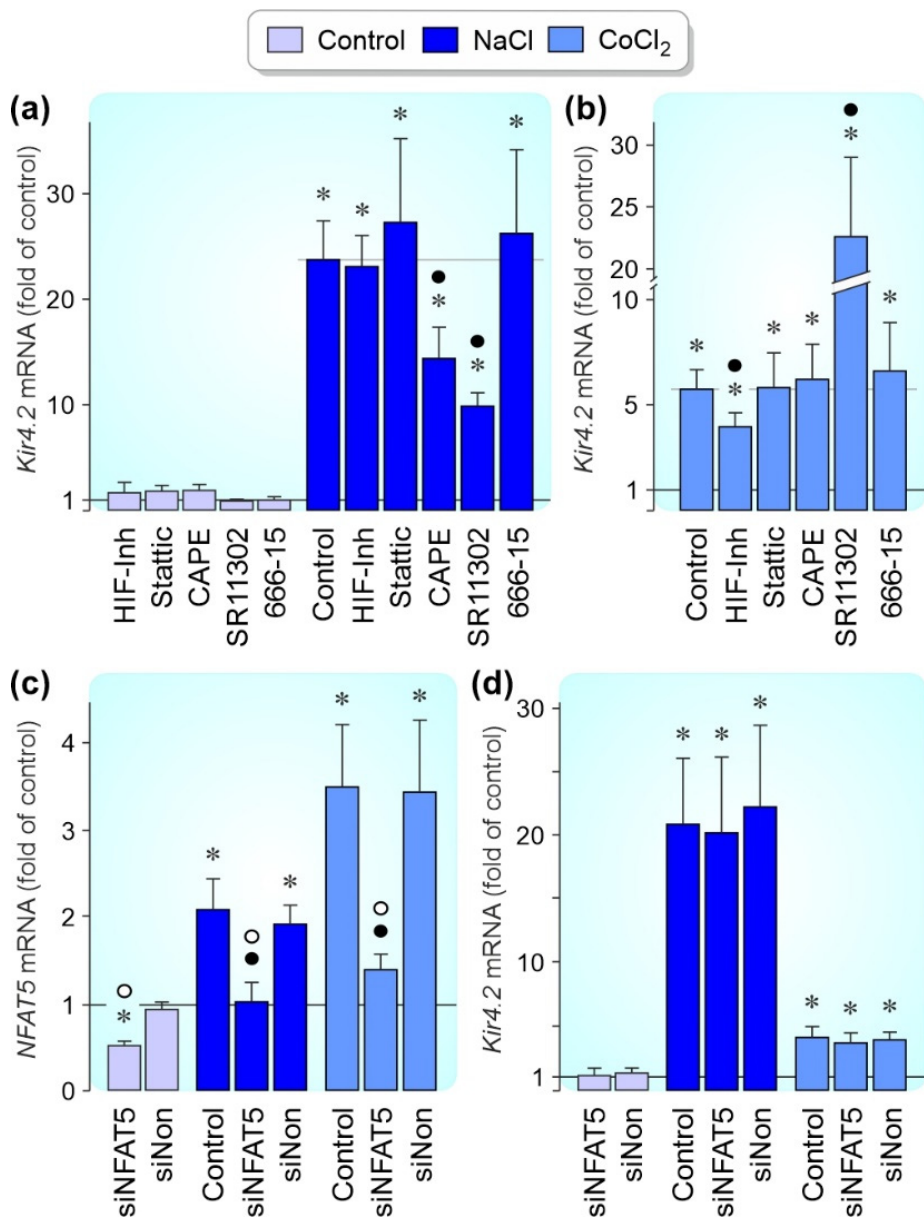
Figure 5. Activities of transcription factors which mediate the hyperosmotic and CoCl 2 -induced expression of the Kir4.2 gene in cultured RPE cells. mRNA levels were examined with real-time RT-PCR analysis. Relative mRNA levels are shown as fold of unstimulated control (1). ( a , b ) The cells were maintained 24 h in the absence (control) and presence of high (+100 mM) NaCl ( a ) and CoCl 2 (150 µM; ( b )), respectively. The effects of a HIF-1 inhibitor (HIF Inh; 5 µM), the STAT3 inhibitor Stattic (1 µM), the NF- κ B inhibitor CAPE (5 µM), the AP-1 inhibitor SR11302 (5 µM), and the CREB inhibitor 666-15 (250 nM) were tested. ( c ) Transfection of the cells with NFAT5 siRNA (siNFAT5; 5 nM) resulted in a reduction of the NFAT5 mRNA level in RPE cells cultured 24 h in the absence (control) and presence of high (+100 mM) NaCl and CoCl 2 (150 µM), respectively. Nontargeted scrambled siRNA (siNon; 5 nM) had no effects. ( d ) Knockdown of NFAT5 gene expression with siRNA (siNFAT5; 5 nM) did not alter the Kir4.2 mRNA level in cells cultured under the three conditions tested. Each bar represents data obtained in 3–7 independent experiments using cells of different donors. Significant difference vs. unstimulated control: * p < 0.05. Significant difference vs. NaCl and CoCl 2 control, respectively: ● p < 0.05. Significant difference between siNFAT5 and siNon: ○ p < 0.05.